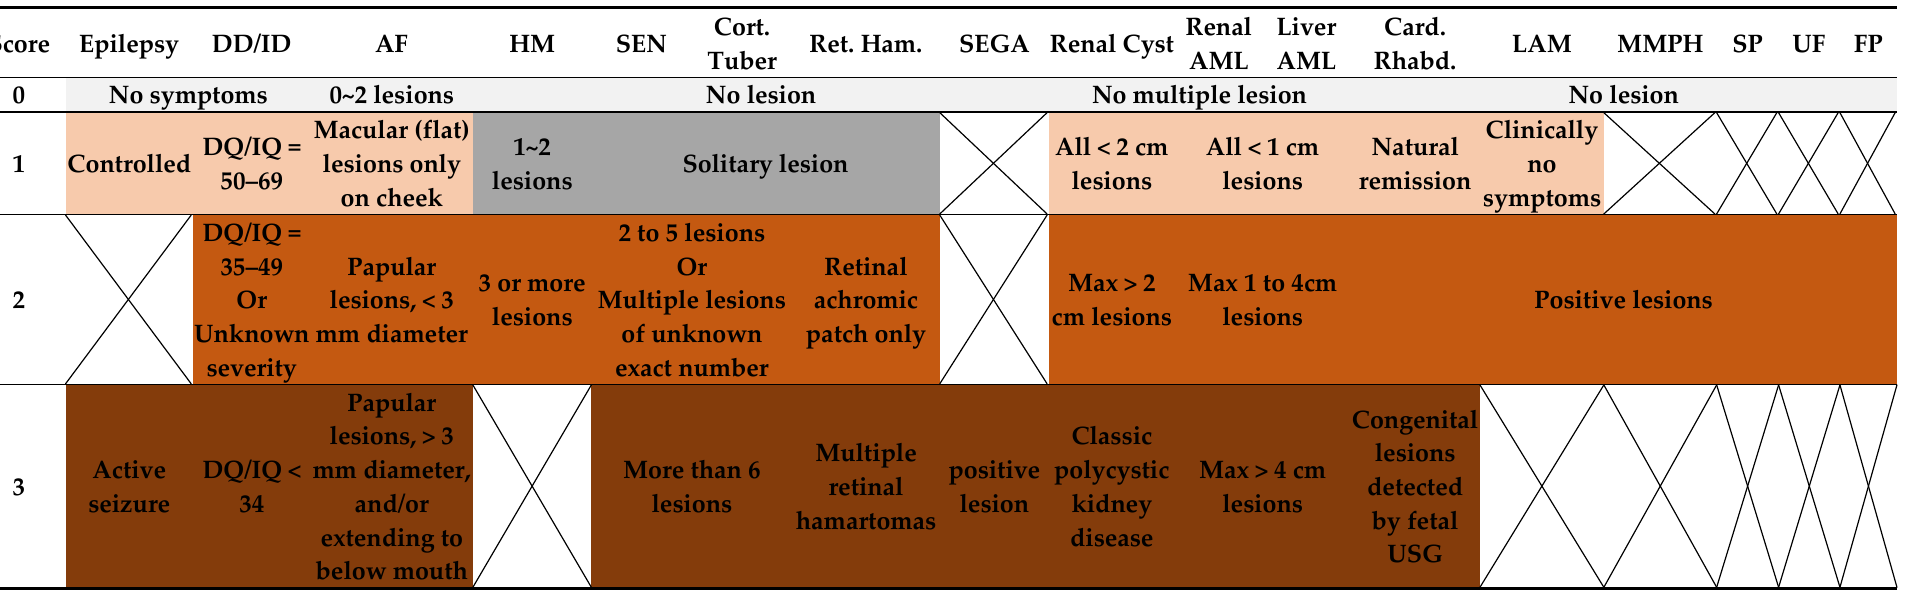
Table 13. Scoring system of clinical manifestations.